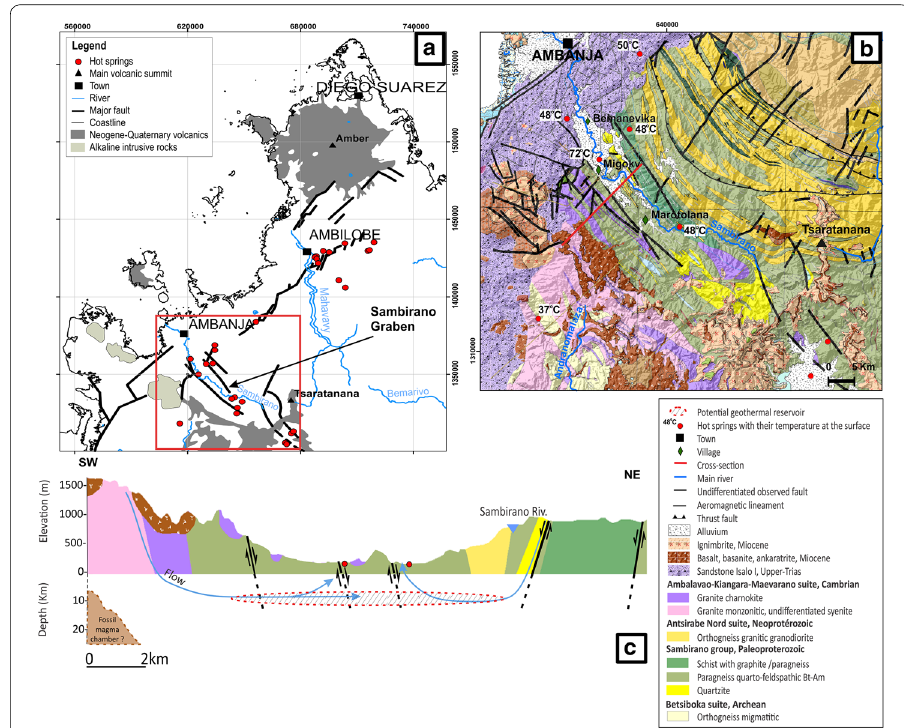
Fig. 3 a Location of Ambanja geothermal area, b detailed geology showing position of thermal springs, modified from Roig et al. (2012), and c conceptual model of the Ambanja geothermal system in the Sambirano graben. The vertical scale of the elevation profile, which was created using ASTER imagery, has been exaggerated compared to the depth scale, which is based on the structure of the crust and uppermost mantle beneath Madagascar (Andriampenomanana et al.